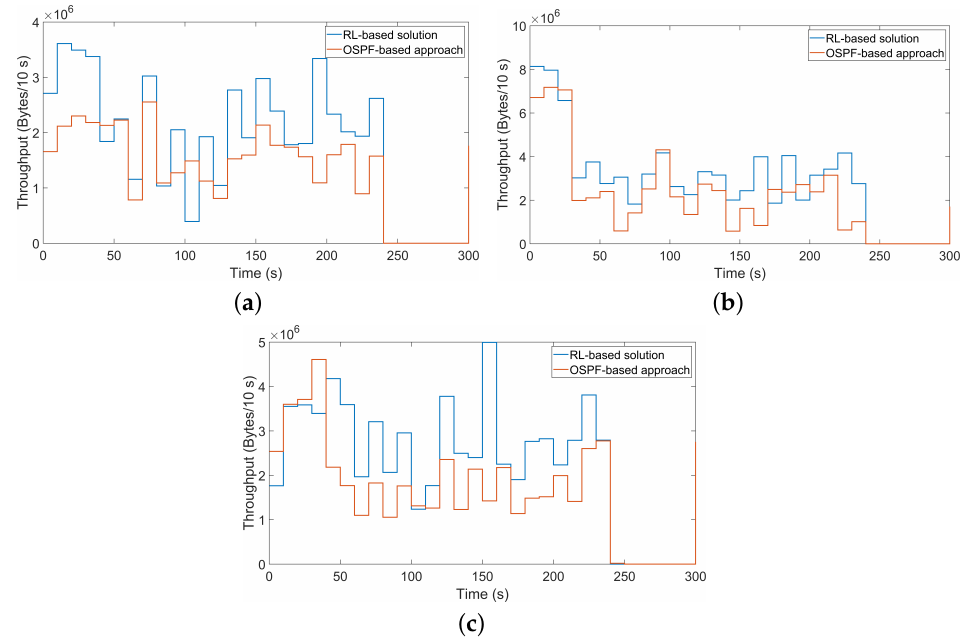
Figure 9. Network throughput during video transmission under high traffic loads in three different topologies. ( a ) Abilene; ( b ) Geant; ( c ) Cernet.